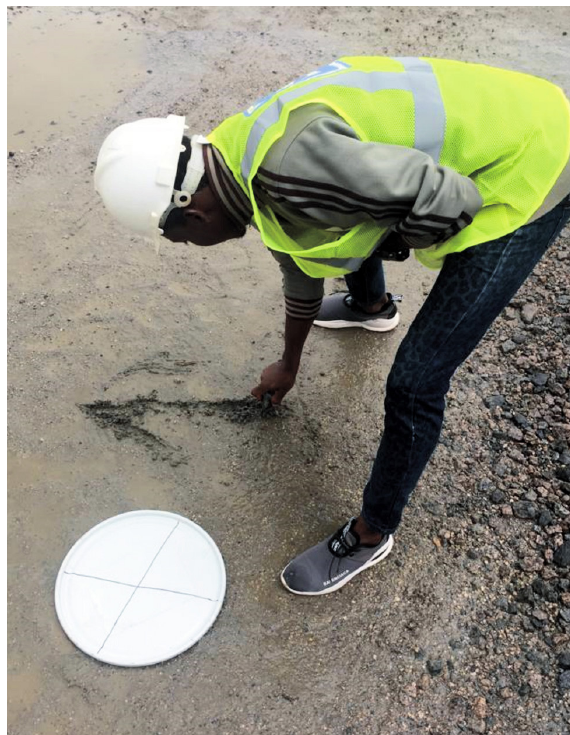
Fig. 3. Ground Control Point (GCP) station selection and